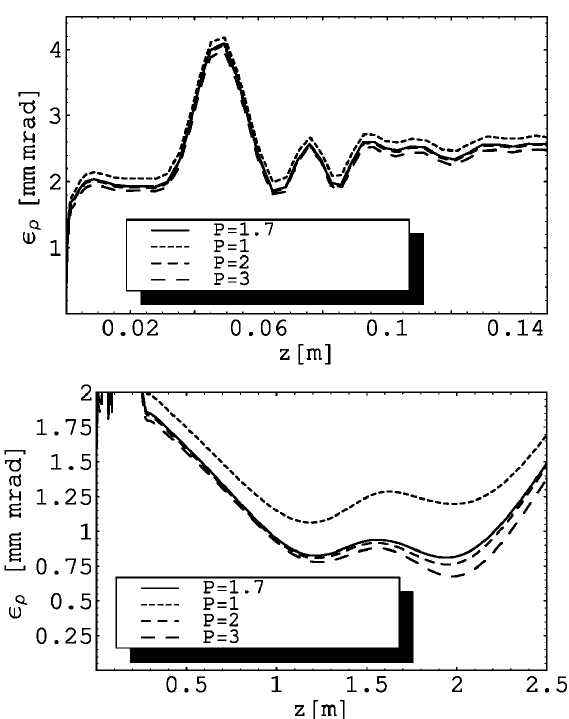
FIG. 12. Radial emittance in the rf gun (top panel) and over the full range (bottom panel) for four different values of impact parameters. The solid lines correspond to the values of P used in the simulations.